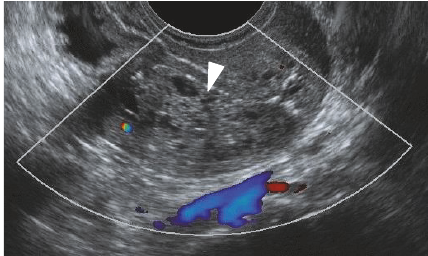
Figure 1: Figures on transvaginal color Doppler ultrasonography , showing a mass in the uterine cavity, measuring 3 × 2 cm and consisting of multiple cysts differing in size (triangle) and without pulsatile blood